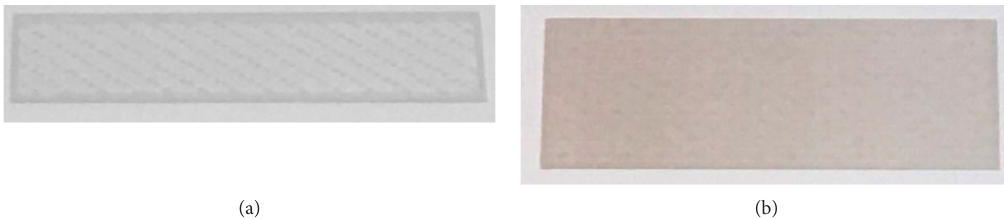
Figure 5: A cross section of 3D-printed samples under different core saturation levels. (a) 100% core saturation. (b) 200% core saturation.